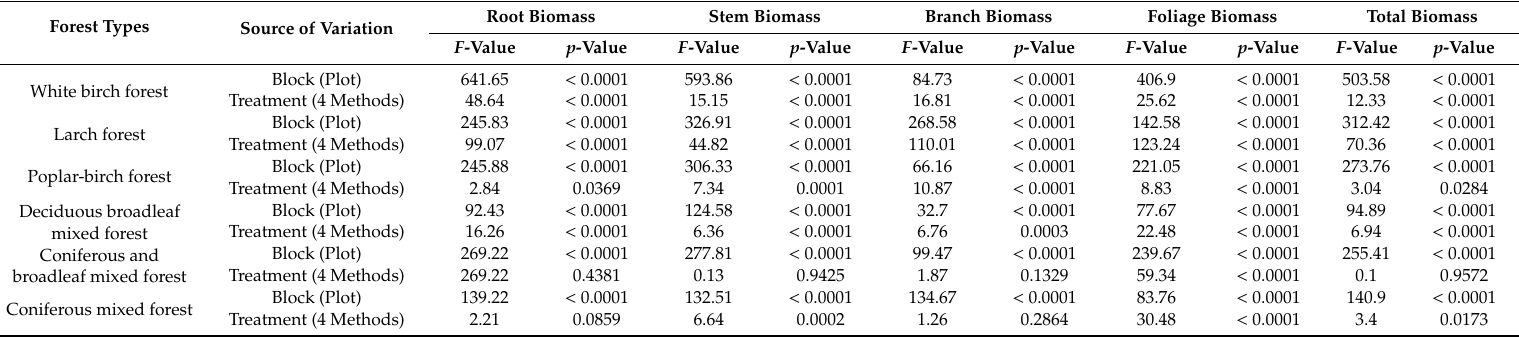
Table 6. Comparison of the four estimation methods of stand biomass of the six forest types in the Eastern Da Xing’an Mountains, Northeast